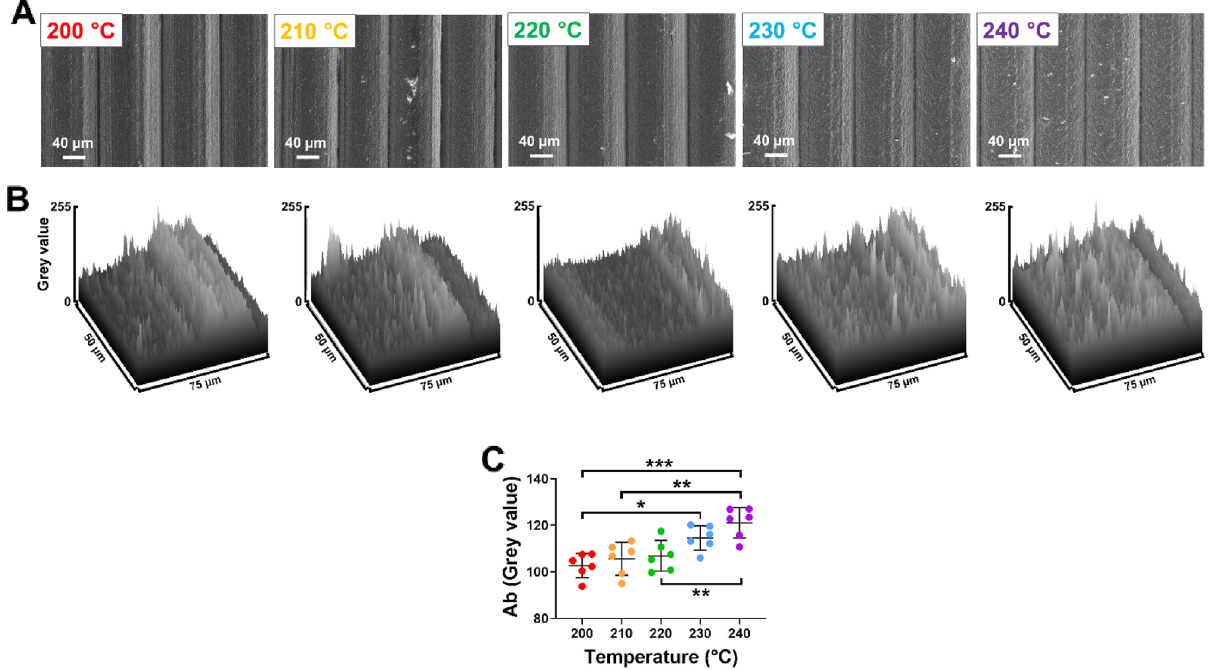
Figure 5. Analysis of the CB/PLA electrode surface. ( A ) Scanning electron microscopy imaging of four print layers of the CB/PLA electrode surface area made at varying extruder temperatures. ( B ) The surface profile analysis of a single print layer and ( C ) analysis of the average surface roughness (Ab) measured in grey values obtained from three print layers of the electrode. Data shown as mean ± SD, where n = 6, * p < 0.05, ** p < 0.01 and *** p <